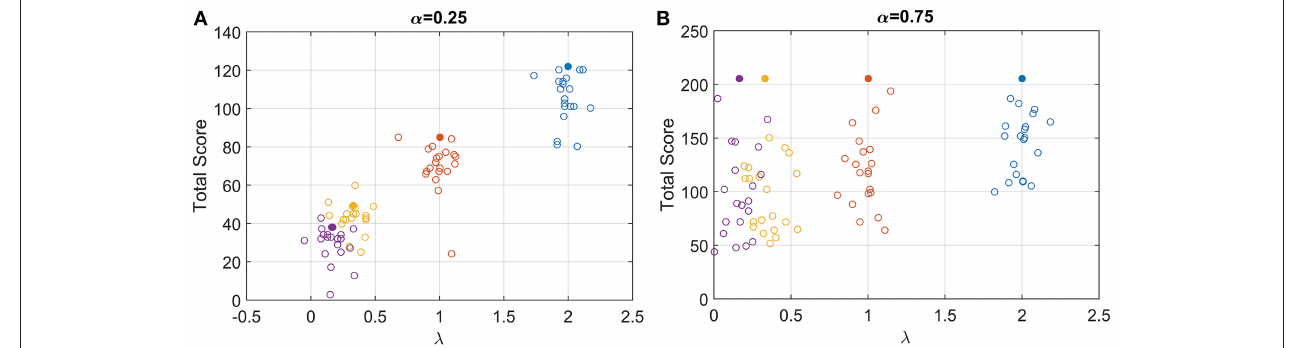
FIGURE 3 | Open circles: total score for each participant for the low (A) and high (B) starting point condition. For clarity, each circle is plotted with a random horizontal offset. Filled circles: expected score with optimum performance for the four speed conditions and the two starting points conditions.